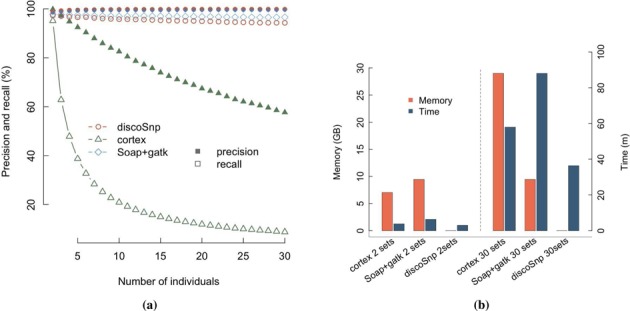
discoSnp, cortex and hybrid strategy (soap + gatk) results, depending on the number of input haploid individuals. Soap and gatk were launched with default parameters. For discoSnp and cortex, k-mers having three or fewer occurrences in all datasets were removed. (a) Precision and recall: filled symbols represent the precision and empty symbols represent the recall. (b) Time and memory performances for two (left part) and 30 (right part) individuals.